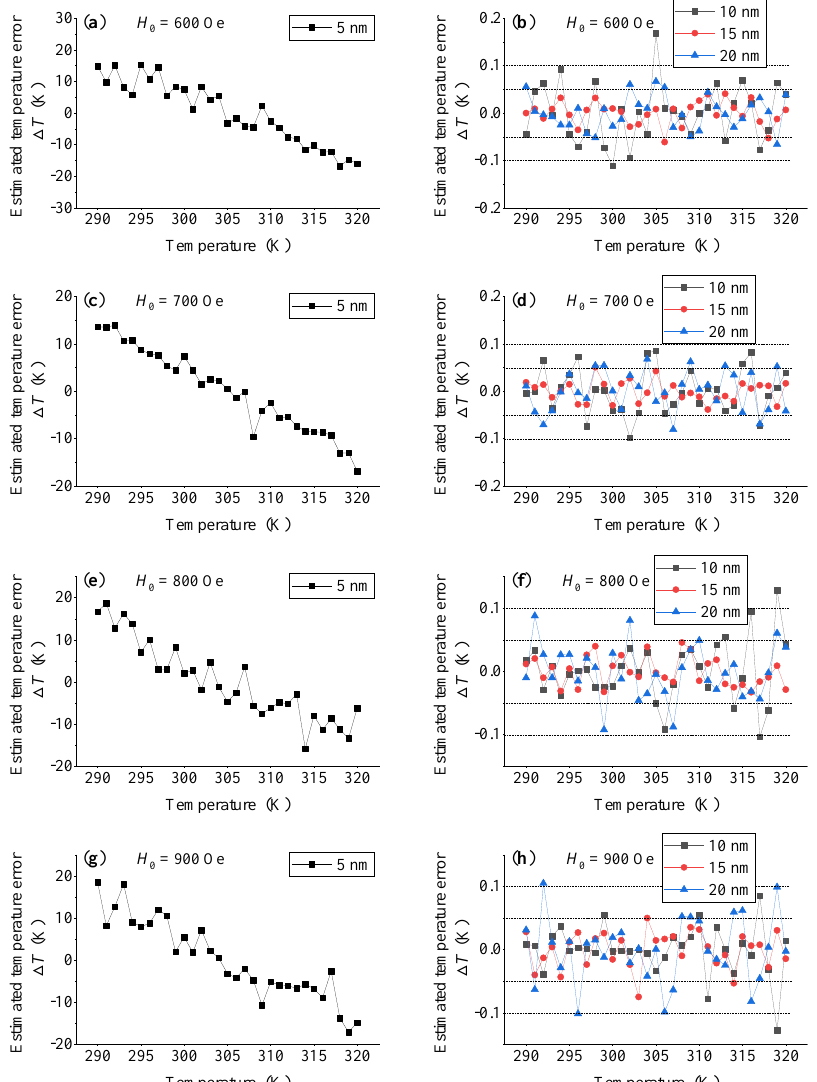
Figure 5. Estimated temperature error ΔT of MNPs with different sizes at different temperature points when H 0 = 600 Oe ( a and b ), 700 Oe ( c and d ), 800 Oe ( e and f ) and 900 Oe ( g and h ), respectively.